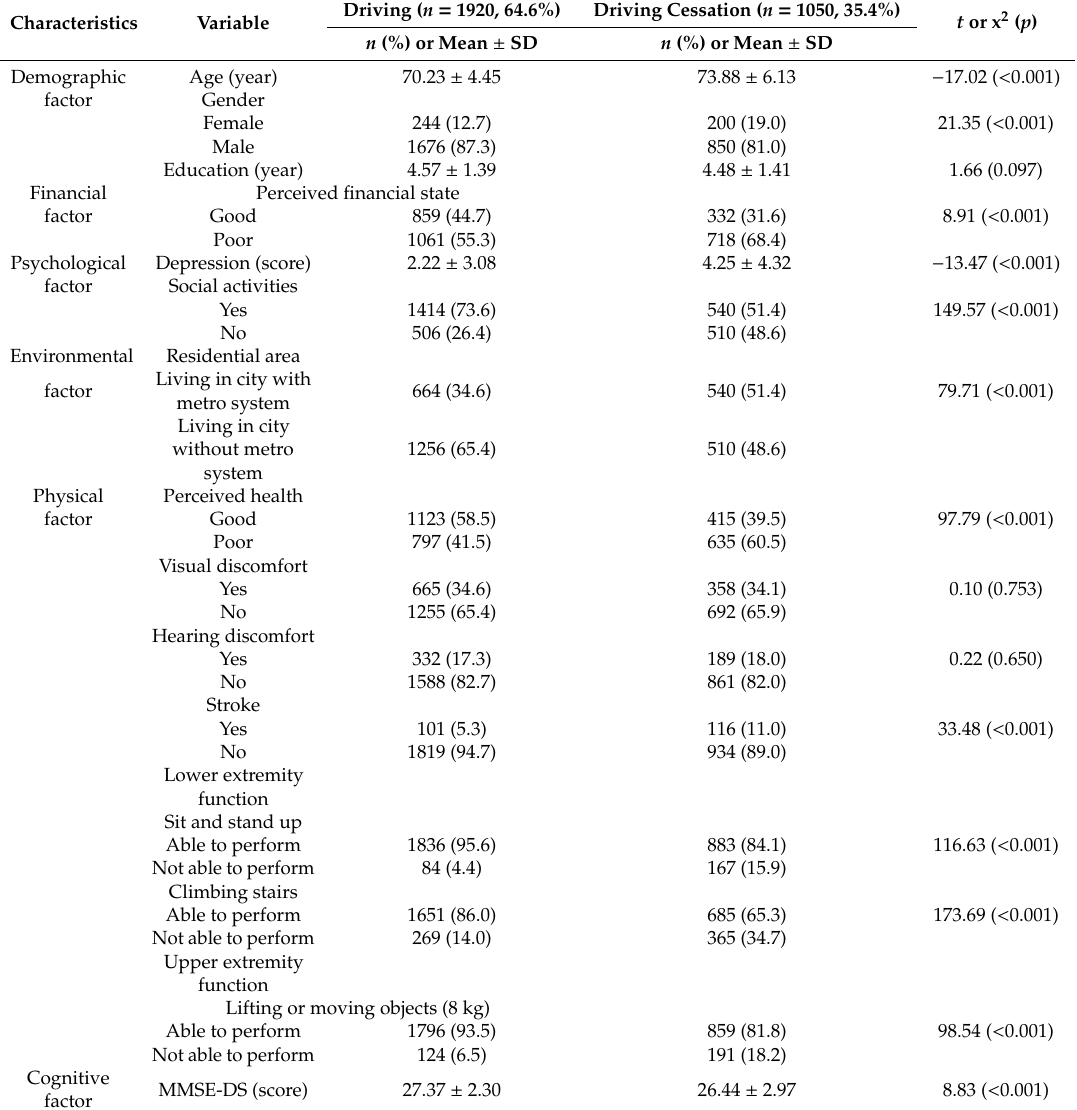
Table 1. General characteristics of the subjects and di ff erences in variables between the driving cessation group and driving group ( N =